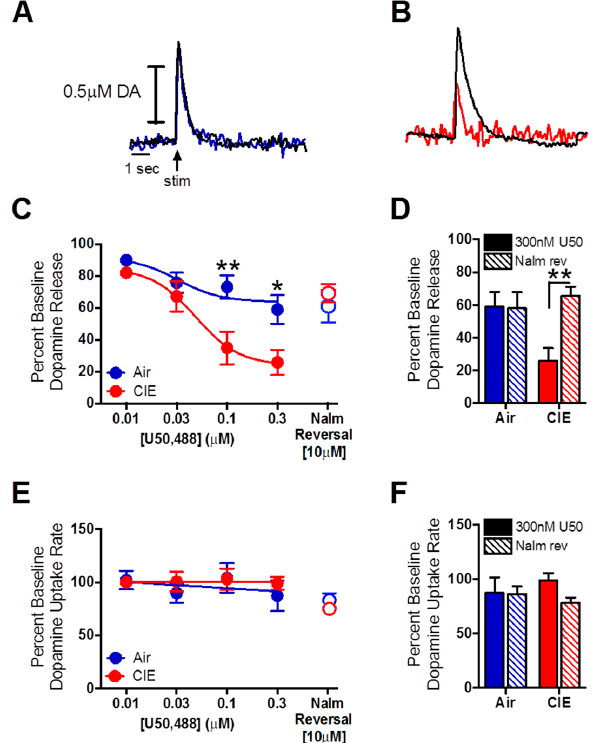
Figure 3. Nalmefene reversed the dopamine-decreasing effects of U50,488 in CIE-exposed mice. ( A ) Representative traces of the effects of 0.3 µM U50,488 on dopamine release in brain slices from air (solid blue) and ( B ) CIE (solid red) exposed mice. The black line (overlaid) represents the effect of 10.0 µM nalmefene on these signals; ( C ) KOR activation with U50,488 dose-dependently reduced dopamine release more in brain slices from CIE-exposed mice compared to controls; ( C , D ) 10 µM nalmefene restored dopamine release following a maximal concentration of the KOR agonist U50,488 in brain slices from CIE-exposed mice to control levels; ( E , F ) U50,488 did not alter dopamine uptake rates across the concentration response curve, and nalmefene had no additional effect on uptake rates in either inhalation group. * p < 0.05, ** p < 0.01. (CIE: chronic intermittent ethanol; KOR: κ opioid